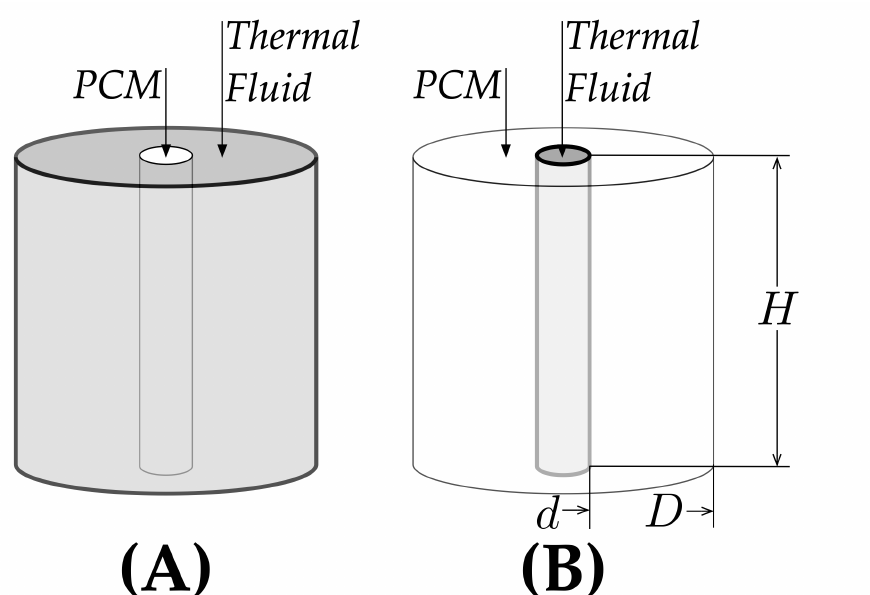
Figure 5. Thermal energy storage system with phase-change material inside a vertical pipe ( A ) or with the thermal fluid inside the vertical pipe ( B